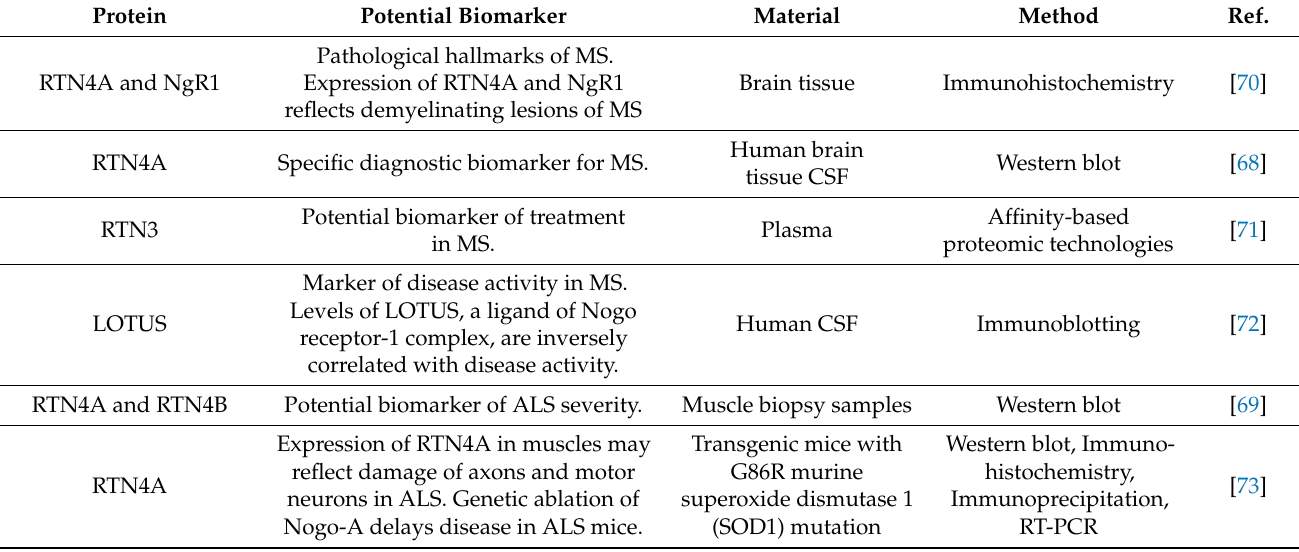
Table 3. RTNs and their partners as candidate biomarkers for